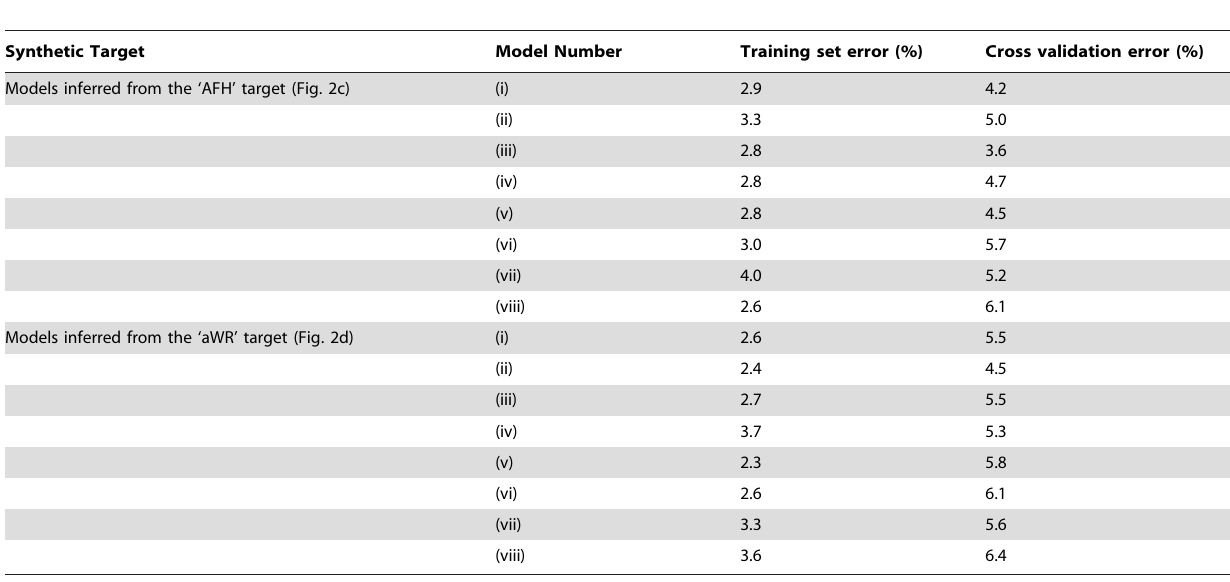
Table 1. Training set and cross validation errors of various models inferred through the informative data obtained from synthetic ‘AFH’ and ‘aWR’ targets (Fig. 3).